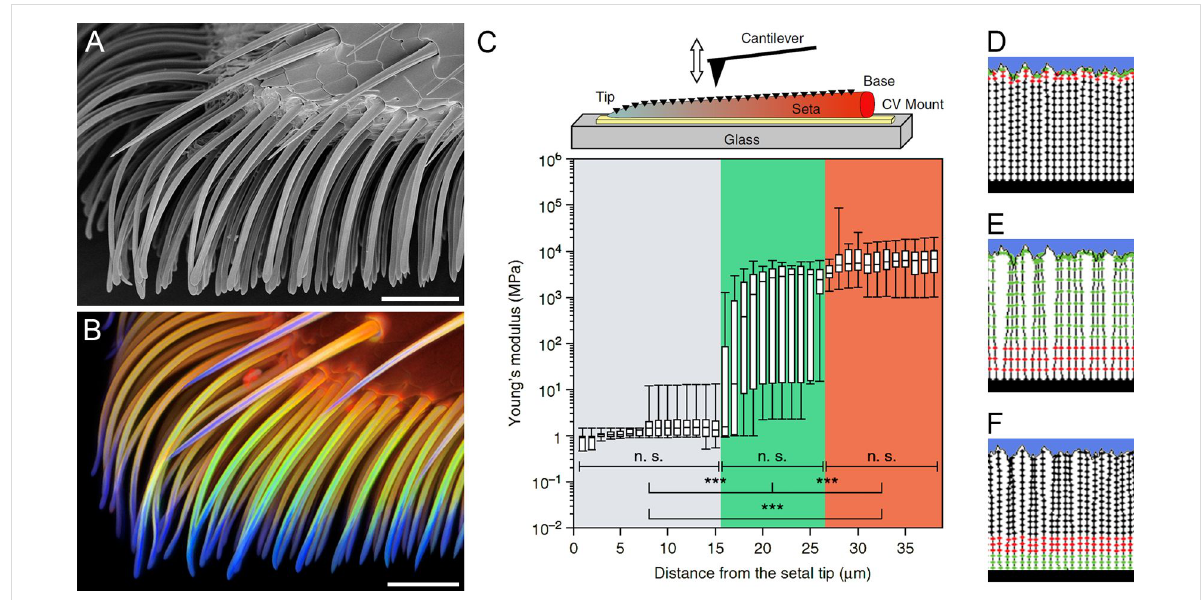
Figure 2: Distribution, mechanical properties and functional significance of resilin in adhesive tarsal setae. (A, B) Ventral part of the second adhesive pad of a female seven-spot ladybird ( Coccinella septempunctata ), lateral view. (A) Scanning electron micrograph. (B) Confocal laser scanning micro- graph (maximum intensity projection) showing an overlay of four different autofluorescences exhibited by the exoskeleton. Blue colour indicates the presence of large proportions of resilin. (C) Box-and-Whisker plots showing the median Young’s modulus of fresh adhesive tarsal setae obtained by atomic force microscopy nanoindentations (see the inset above the graph) along each seta. The borders of the boxes define the 25th and 75th percentiles, the median is indicated by a horizontal line, and the error bars define the 10th and 90th percentiles (n. s. = not significant, *** = highly sig- nificant). The background colours indicate the different seta sections. (D–F) Numerical model showing typical configurations of a filamentary structure (setal array) attached to a stiff support (black rectangle) in adhesive contact with a random fractal surface (blue region). Three types of fibres were tested: (D) stiff fibres with short elastic ends, (E) long elastic fibres connected to the base by short stiff roots and (F) stiff fibres with soft elastic seg- ments near the base. The different stiffnesses of the segments are conditionally shown by circles with different colours. Stiff, medium and soft seg- ments are marked by black, red and green circles, respectively. Scale bars = 25 µm (A, B). (A–C) Adapted with permission from [48], copyright 2013 Nature Publishing Group. (D–F) Adapted with permission from